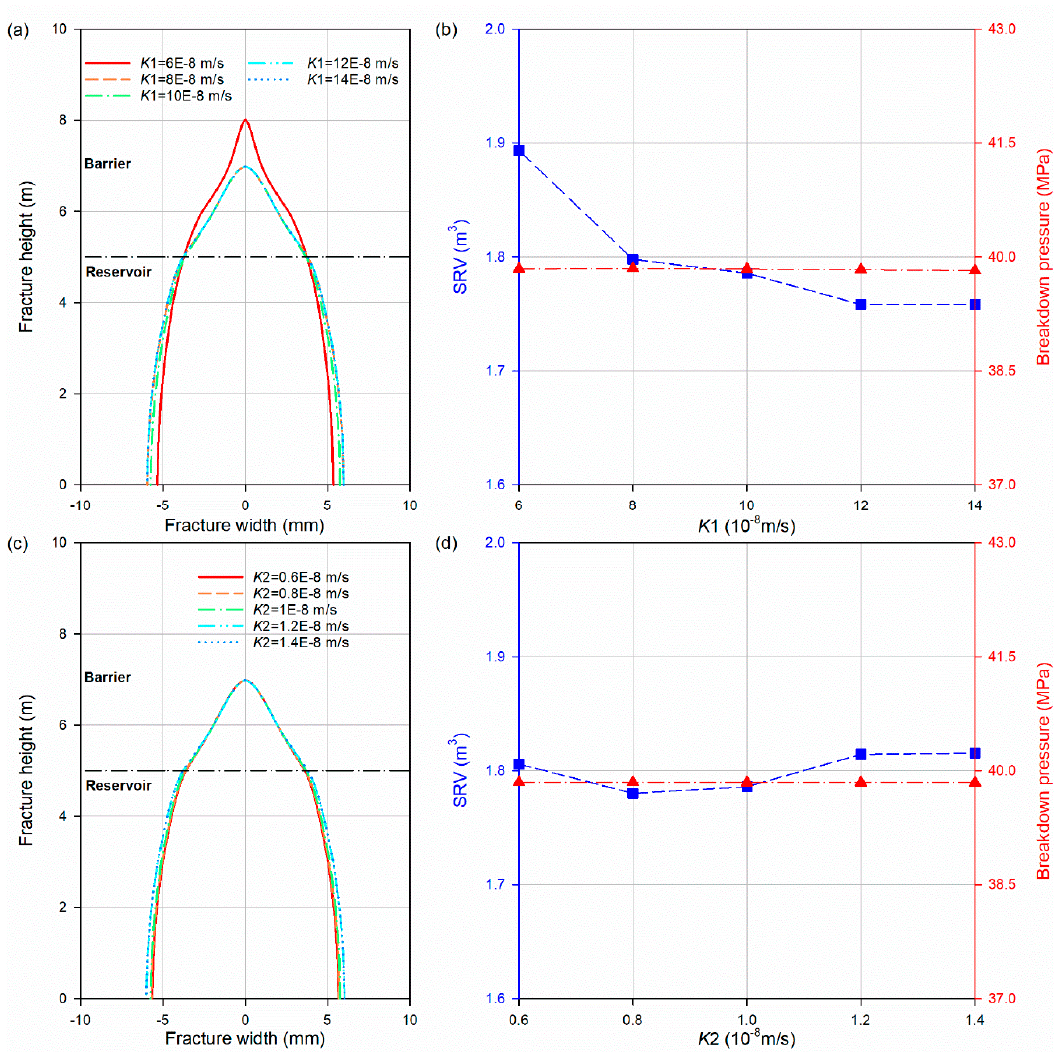
Figure 16. Fracture morphology, SRV, and breakdown pressure under different permeability coefficients. ( a ) Profiles of fractures under different reservoir permeability coefficient K 2; ( b ) SRV and breakdown pressure under different K 1; ( c ) profiles of fractures under different barrier permeability coefficient K 2; ( d ) SRV and breakdown pressure under different K 2.